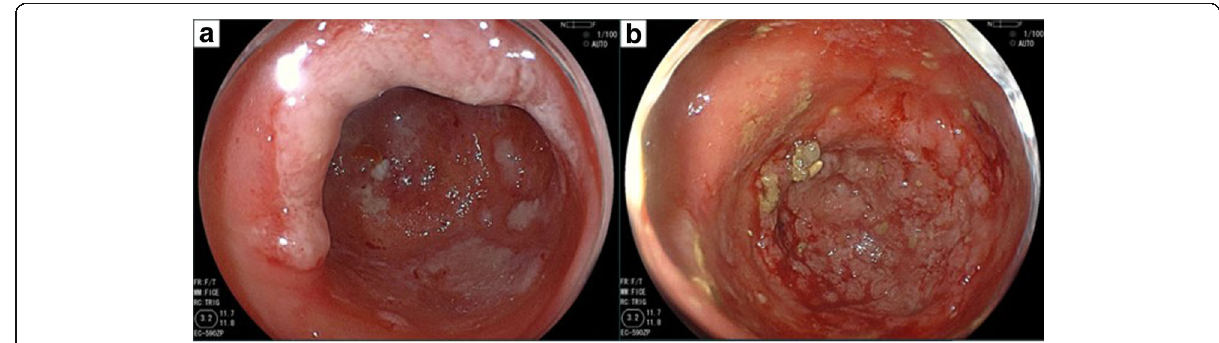
Fig. 2 Colonoscopy showed two diverticula of the sigmoid colon containing elevated lesions. a The proximal lesion had erythema with marginal erosion. b The distal lesion had irregularly elevated